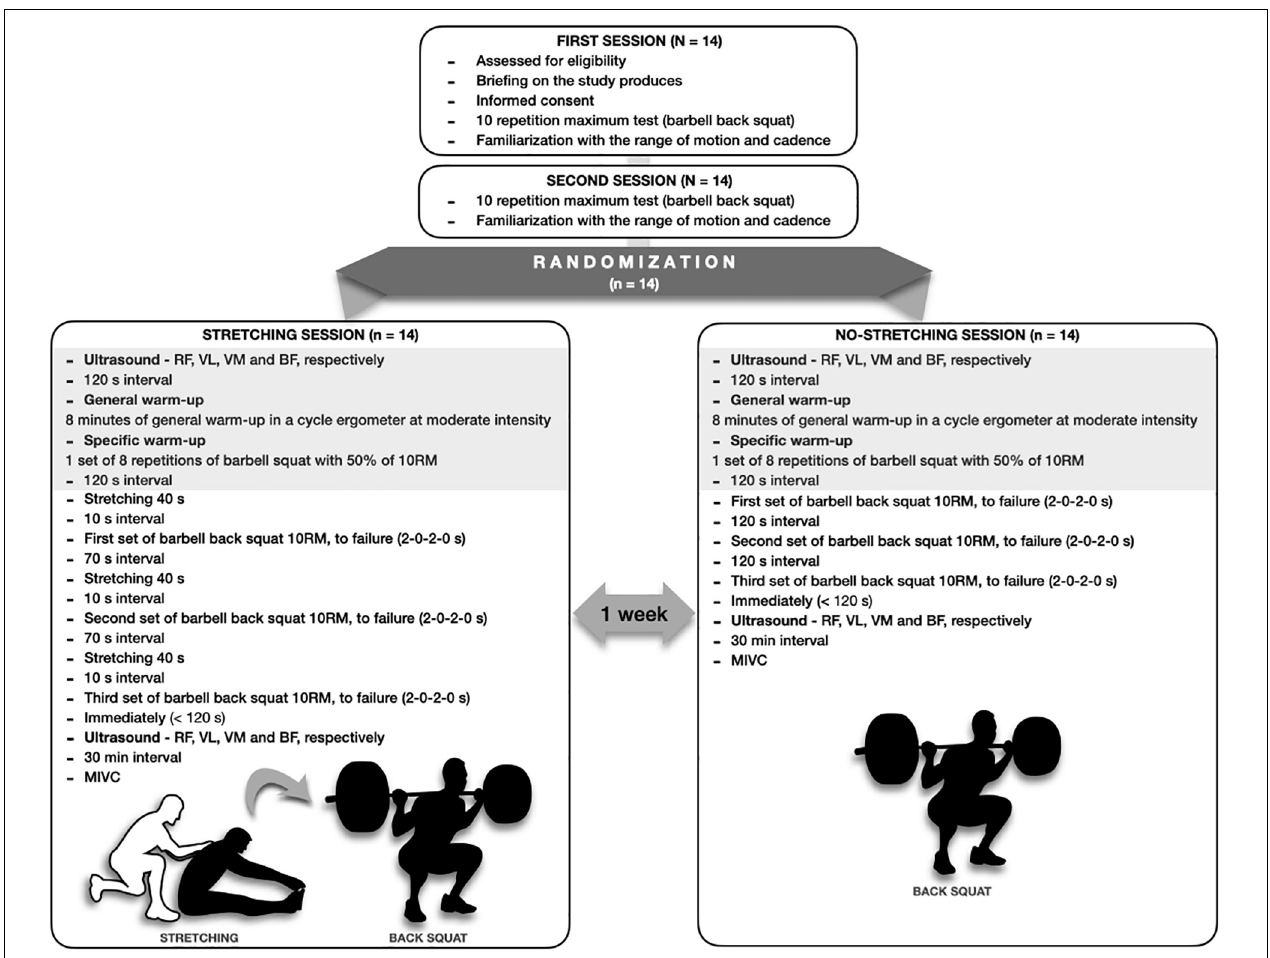
FIGURE 1 | Experimental